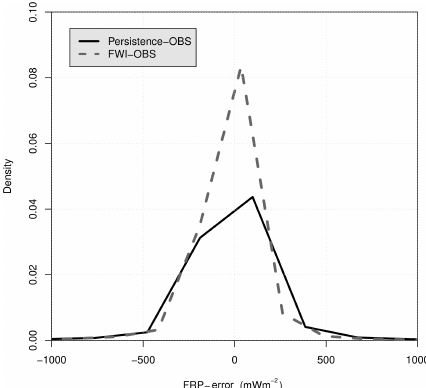
Figure 5. Global verification of FRP against observations. Proba- bility density functions (PDFs) of the observed FRP departure of MODIS compared to the two observation operator models relying on the assumption of persistence and on the